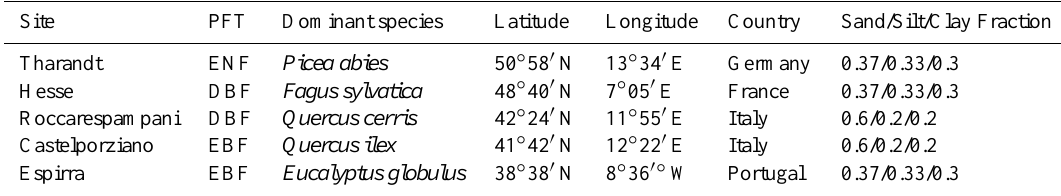
Table 2. Summary of flux tower sites.